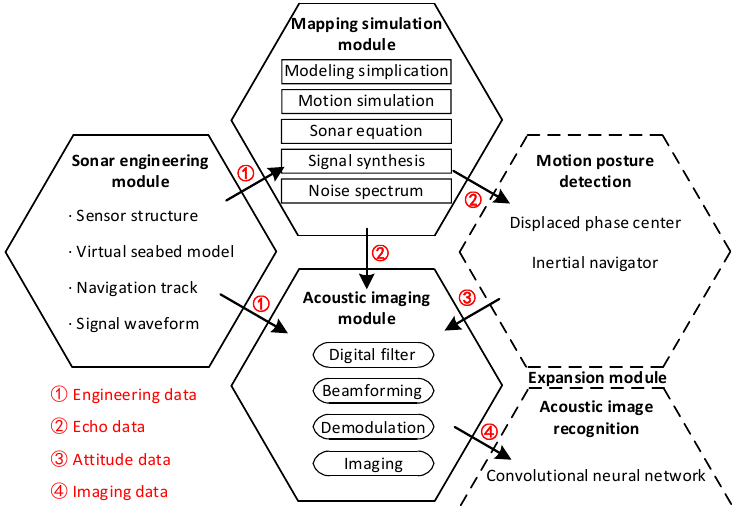
cial processing segments and maintain dynamic operation relations. Figure 2. Sonar simulator framework as a two − level network architecture. Figure 2. Sonar simulator framework as a two–level network architecture.